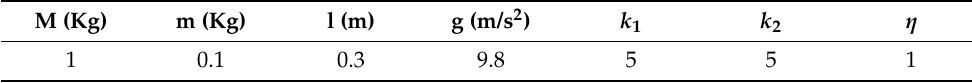
Table 1. Inverted Pendulum System and Controller